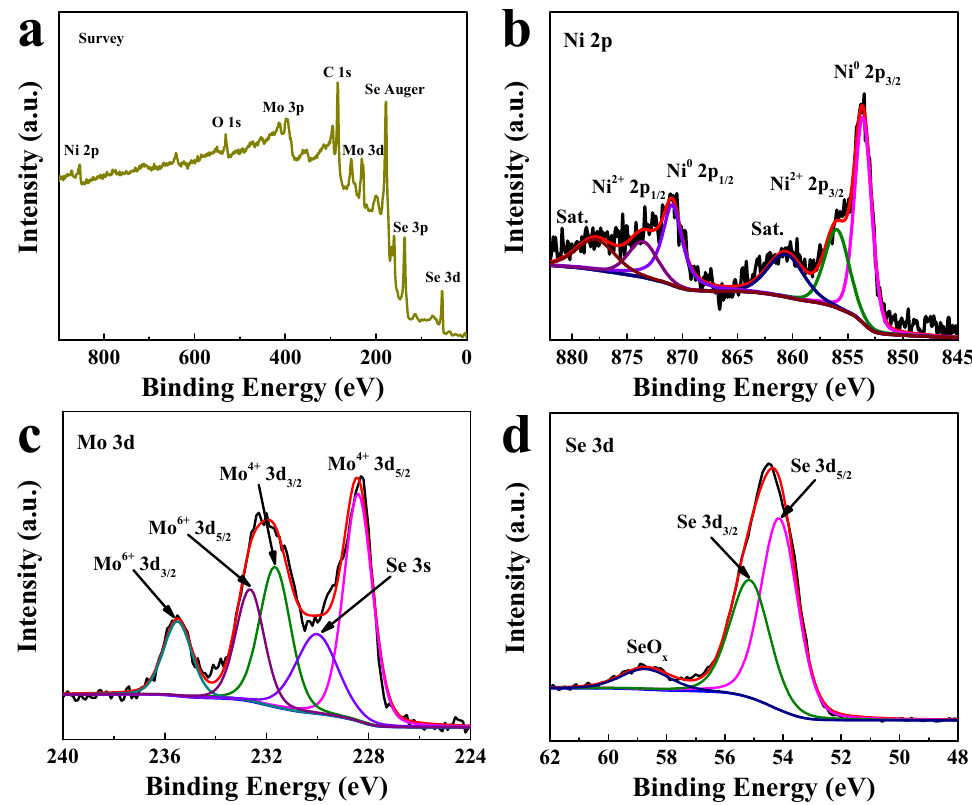
Figure 2. XPS spectra of NiSe 2 -MoSe 2 HTs/G composite: ( a ) survey, ( b ) Ni 2p, ( c ) Mo 3d, and ( d ) Se 3d.